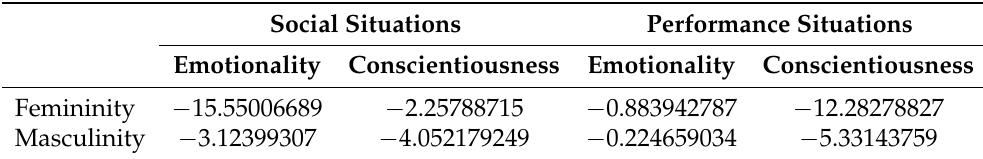
Table 12. Core G with the DisjointTuckerALS algorithm for behavioral level